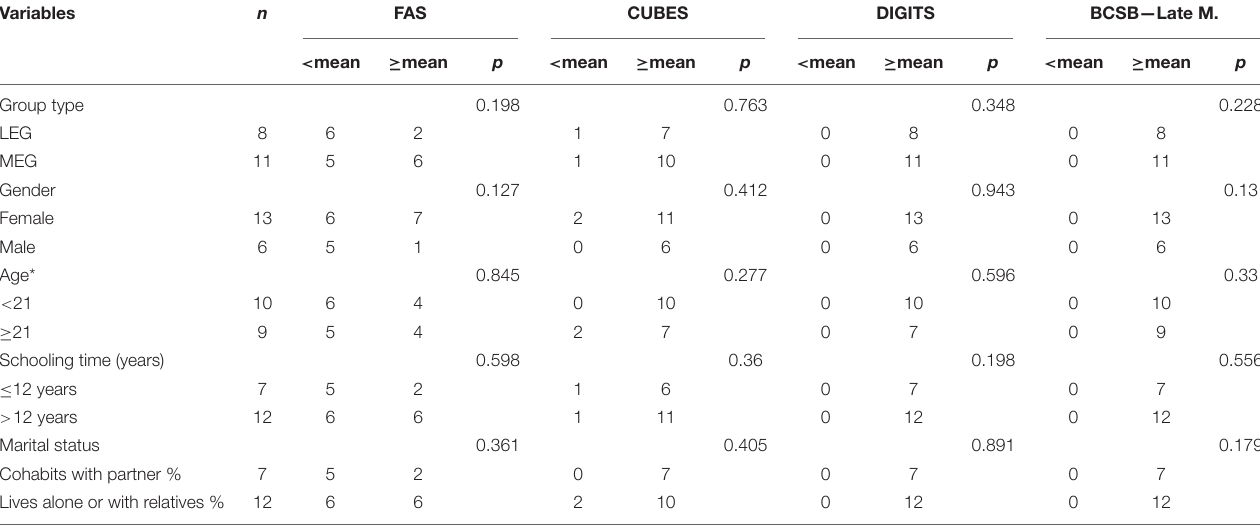
TABLE 3 | Performances in FAS, CUBES, DIGITS subtest with respect to group and socio-demographic variables in subjects practicing trance mediumship. Variables n FAS CUBES DIGITS BCSB—Late M.